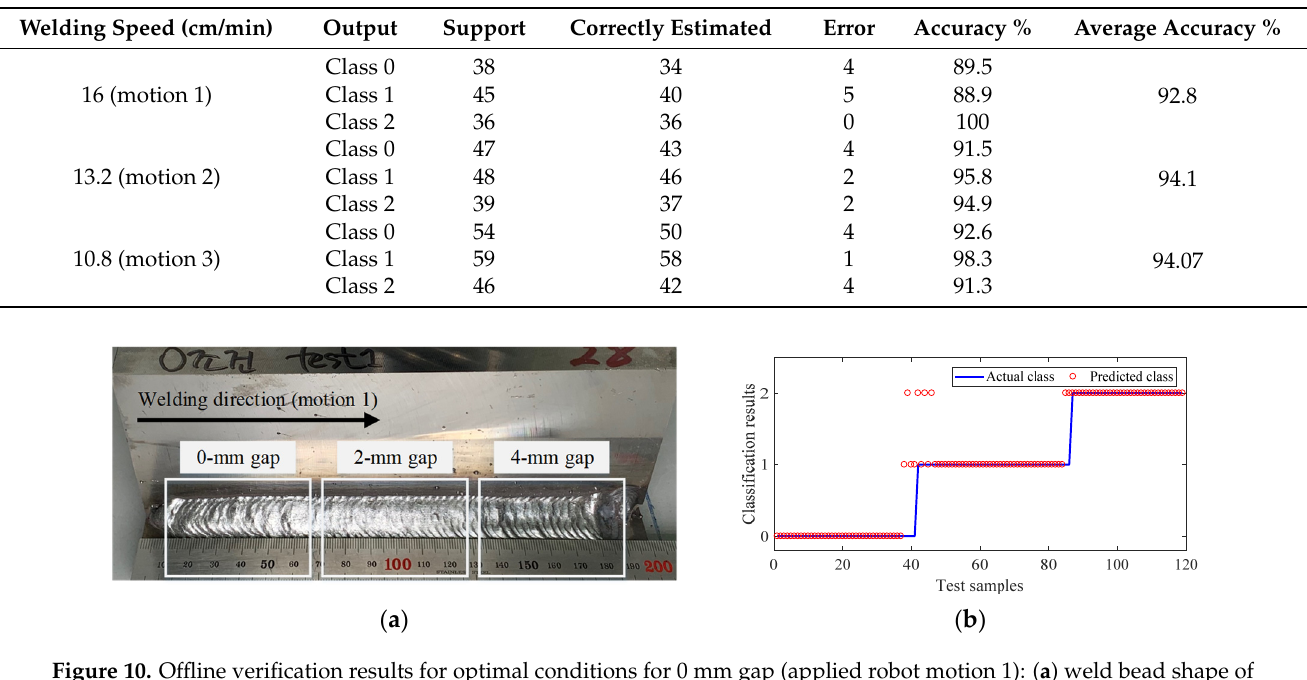
Figure 9 . Frame designation of welding current data: ( a ) the test plate used for offline verification and ( b ) the test plate used for online verification. Table 7. Weld gap monitoring performance of the proposed DNN model.